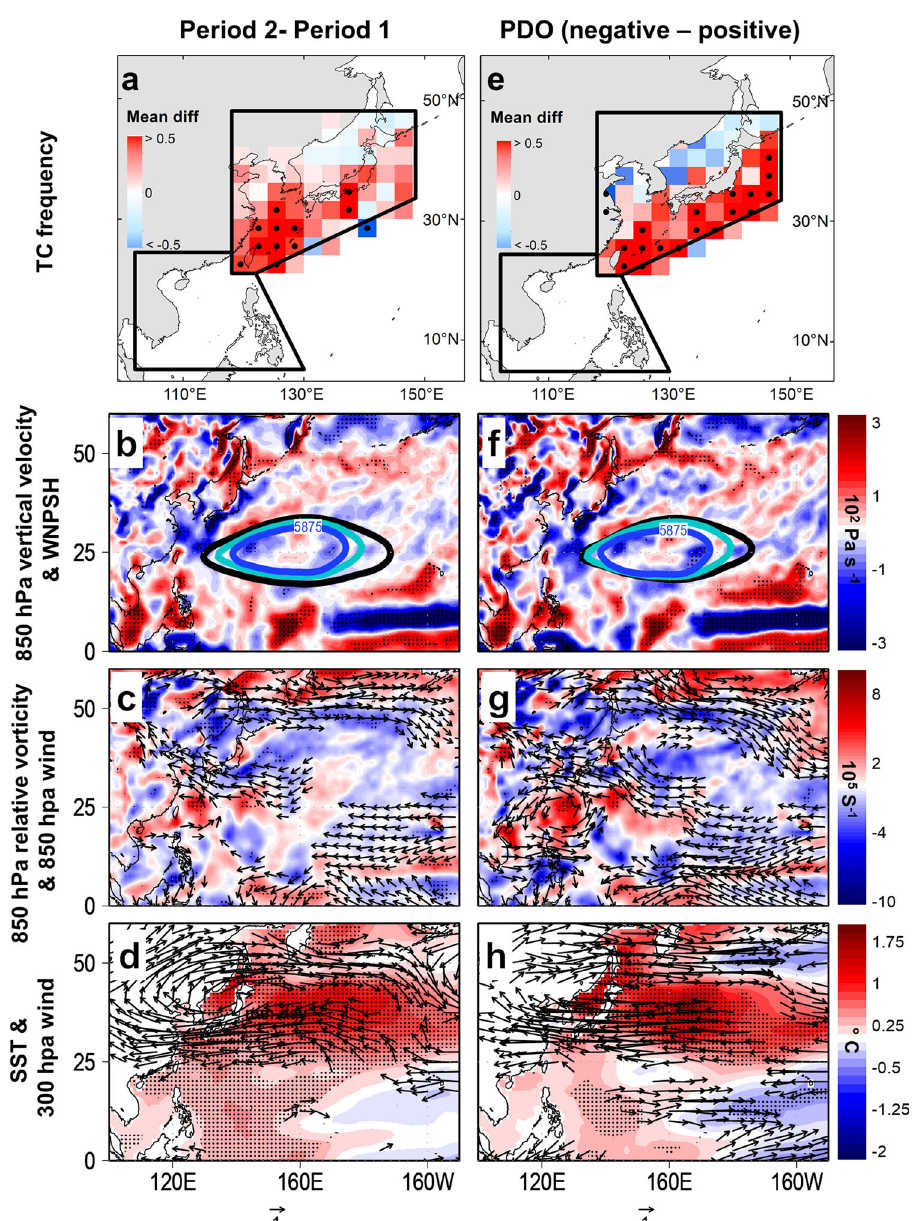
Fig. 4 Composite difference maps in the large-scale environment during the mature boreal autumn. The composite difference of large- scale environment between the Period 2 and Period 1 (left panel), and positive and negative PDO phase (right panel) for a, e tropical cyclone passage frequency, b , f 850 hPa pressure vertical velocity, c , g 850 hPa relative vorticity (shaded) and 850 hPa wind (vector), and d , h sea surface temperature (shaded) and 300 hPa wind (vector) In a − h , the black dots represent signi fi cant difference at p < 0.05. In b , f , the (black) blue and cyan lines represent the (climatological) location of the Western North Paci fi c subtropical high ( = 5875 gpm) during Period 1 and Period 2, respectively. In c , g , the 850 hPa relative vorticity is multiplied with 1,000,000 for scaling. Signi fi cance is tested using student ’ s t-test statistic with two-tailed